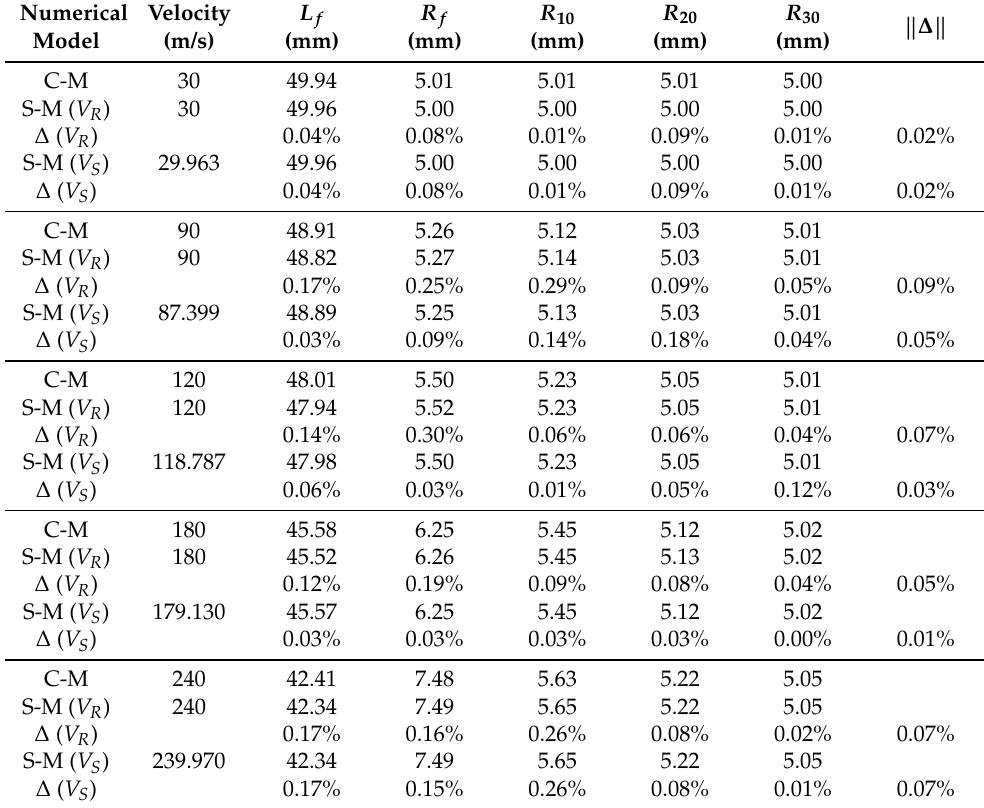
Table 4. Identification of the equivalent impact velocity V S for the simplified model of the Taylor